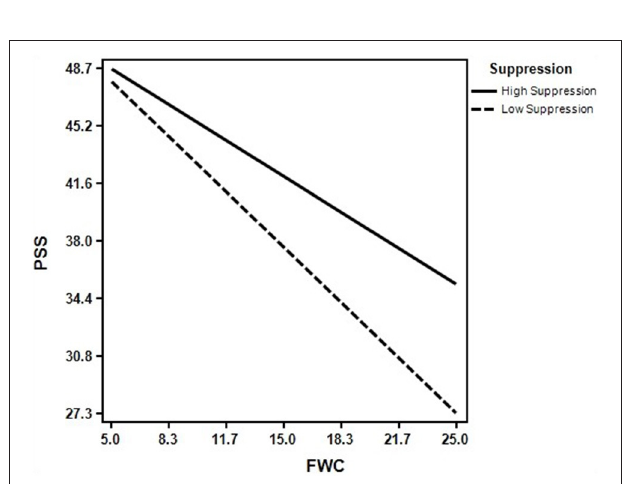
FIGURE 4 | The moderating effect of suppression on family-work conflict to perceived social